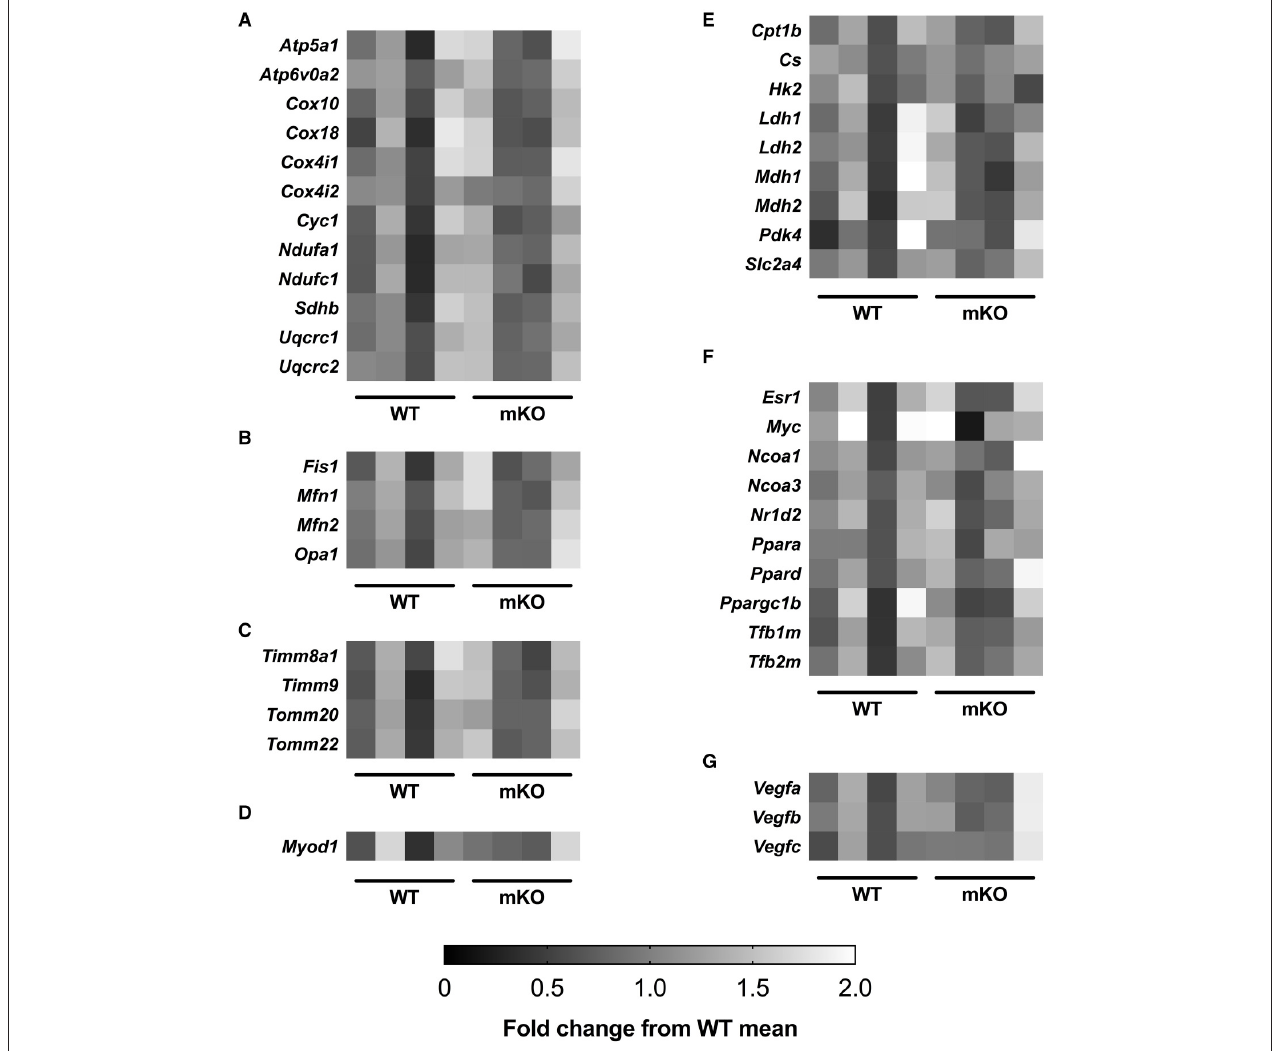
FIGURE 6 | p53 mKO and WT mice display similar mRNA expression of (A) electron transport chain proteins and proteins involved in regulating (B) mitochondrial morphology, (C) mitochondrial protein transport, (D) muscle development, (E) carbohydrate and fatty acid metabolism, (F) transcription and (G) angiogenesis. Each column represents the mRNA expression from the quadriceps muscle of a single mouse ( p > 0.05; n = 4 per